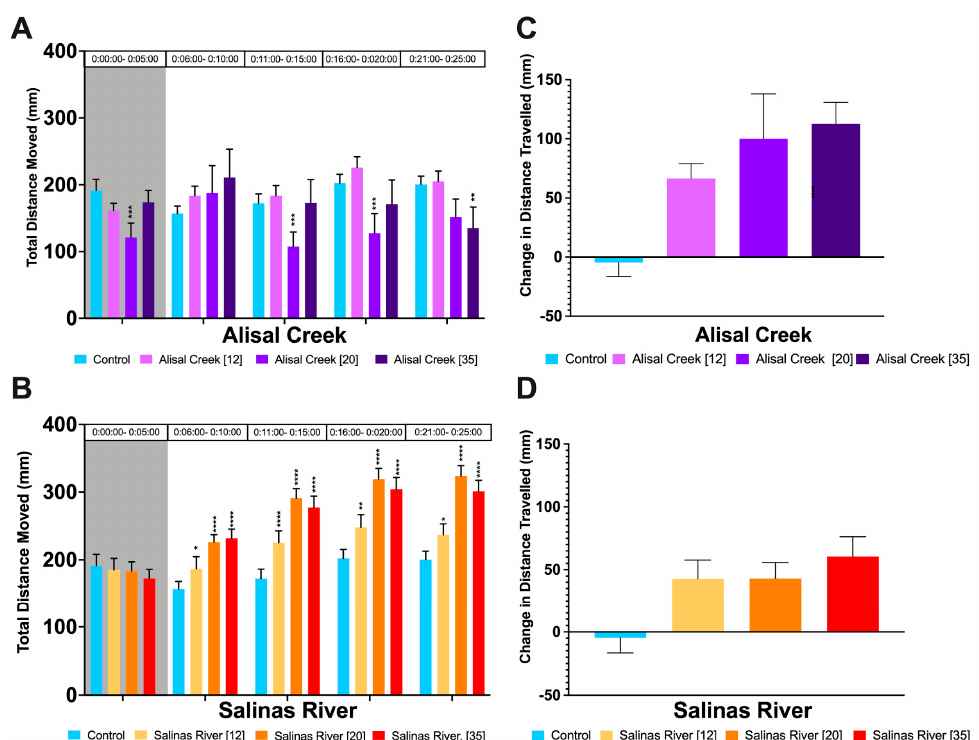
Figure 1. Swimming Behavior of D. magna after Exposure to Water Samples from the Salinas Valley Watershed collected in September 2019 (before first flush). ( A , B ) Average total distance moved (mm) of D. magna after 96 h of exposure to water samples from ( A ) Alisal Creek or ( B ) Salinas River. ( C , D ) Photomotor response of D. magna after 96 h of exposure to water samples from ( C ) Alisal Creek or ( D ) Salinas River, calculated by taking the difference between the average distance moved in the last minute of dark and the first minute of light. The significance of Tukey’s Multiple Comparisons tests is shown as * = p ≤ 0.05, ** = p ≤ 0.01, *** = p ≤ 0.001, **** = p ≤ 0.0001. Error bars depict standard error.